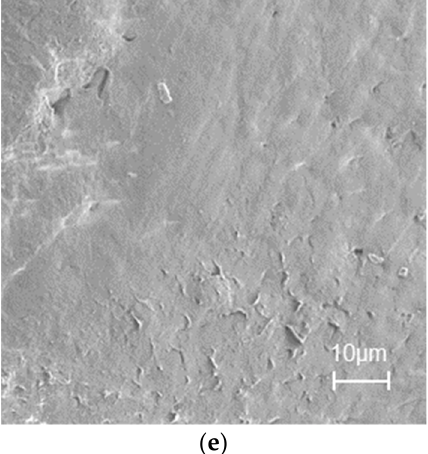
Figure 2. SEM images of injection-molded cellulose ester blends at 1000× magnification (scale bar = 10 µm): ( a ) Cellulose C16; ( b ) cellulose C8; ( c ) cellulose C16/C8, 75%:25%; ( d ) cellulose C16/C8, 50%:50%; ( e ) cellulose C16/C8, 25%:75%.